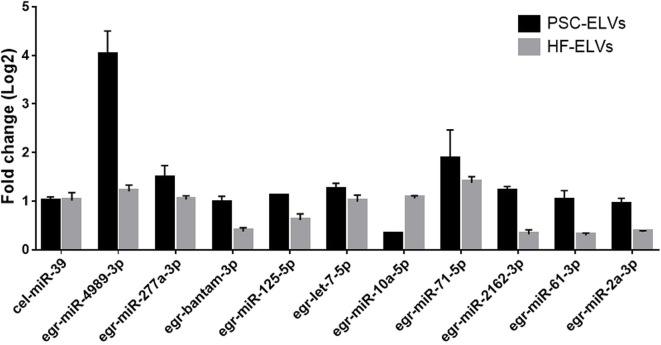
Identification of abundant miRNAs in PSC-ELVs and HF-ELVs using qPCR. Cel-miR-39 acted as external control to confirm normalization of sample-to-sample variation. Results are presented as log2-fold changes in expression ± standard error.